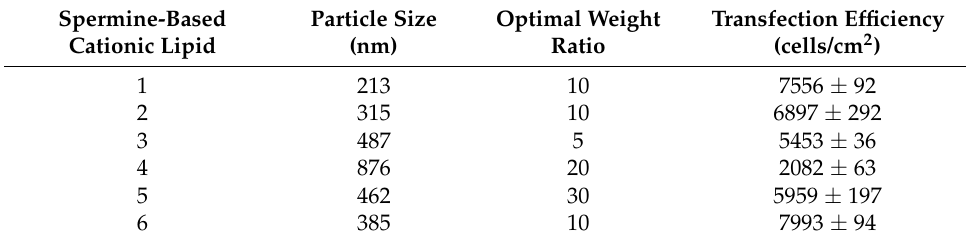
Figure 2. Spermine-based cationic lipids synthesized and evaluated as non-viral carriers for DNA plasmid. Table 1. Particle size, optimal weight ratio and transfection efficiency for cationic nioplexes made up of DNA plasmid and a mixture of spermine derivatives, Chol and Span-20.